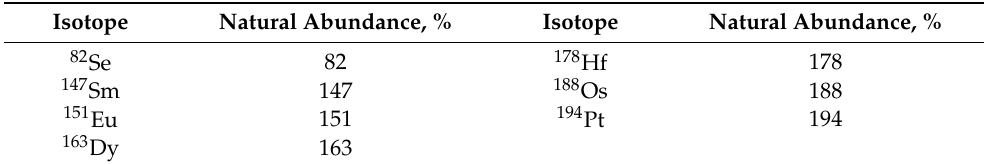
Table 4. Recommended isotopes for adjusting difficult-to-detect elements in the analysis of gadolinium-based solutions. Isotope Natural Abundance, % Isotope Natural Abundance, % 82 Se 82 178 Hf 178 147 Sm 147 188 Os 188 151 Eu 151 194 Pt 194 163 Dy